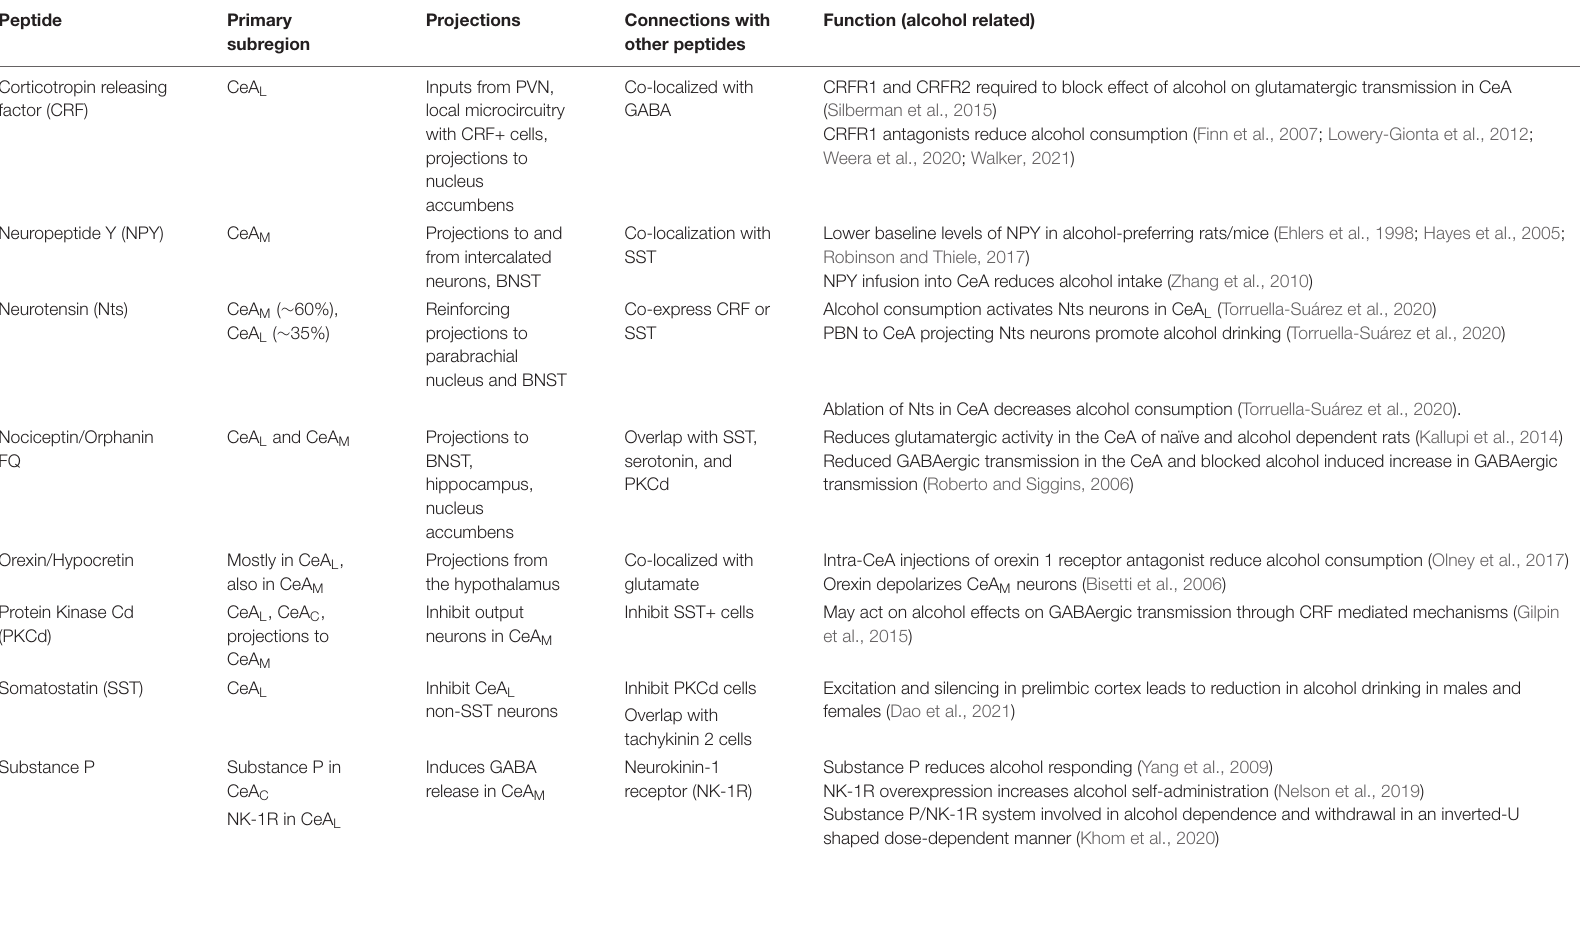
TABLE 5 | Commonly studied neuropeptides in the CeA modulating alcohol related effects. Peptide